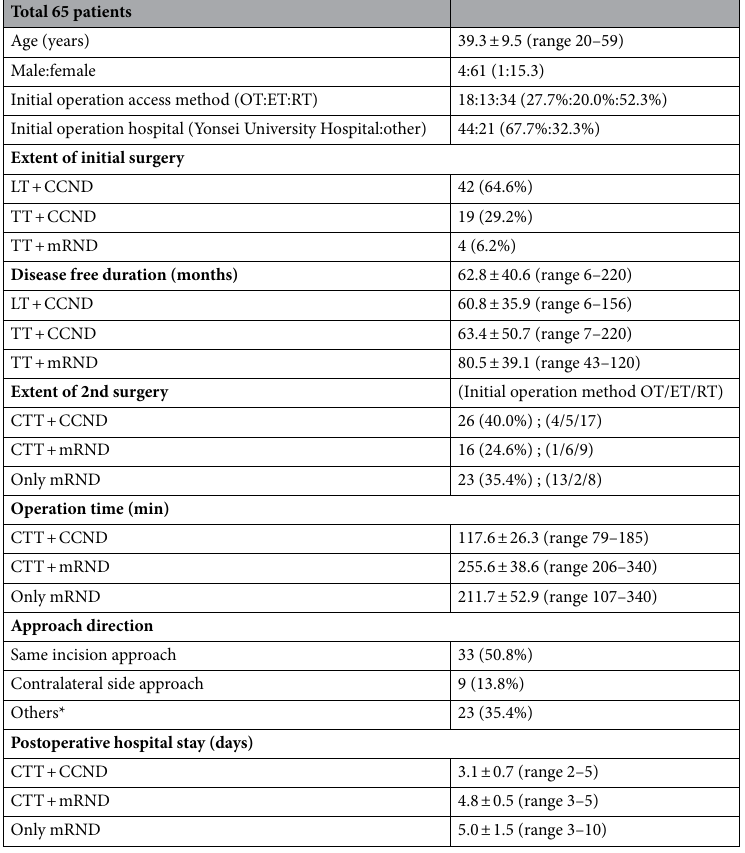
Table 1. Baseline clinical characteristics of re-do robotic operation. Data are expressed as patient number (%) or mean ± SD. OT open thyroidectomy, ET endoscopic thyroidectomy, RT robotic thyroidectomy, LT less than total thyroidectomy, TT total thyroidectomy, CTT completion total thyroidectomy, CCND central compartment neck node dissection, mRND modified radical neck dissection, BABA bilateral axillo-breast approach thyroidectomy. *Others include one bilateral approach case due to bilateral neck node recurrence and not applicable cases such as initial open thyroidectomy or BABA approach thyroidectomy.